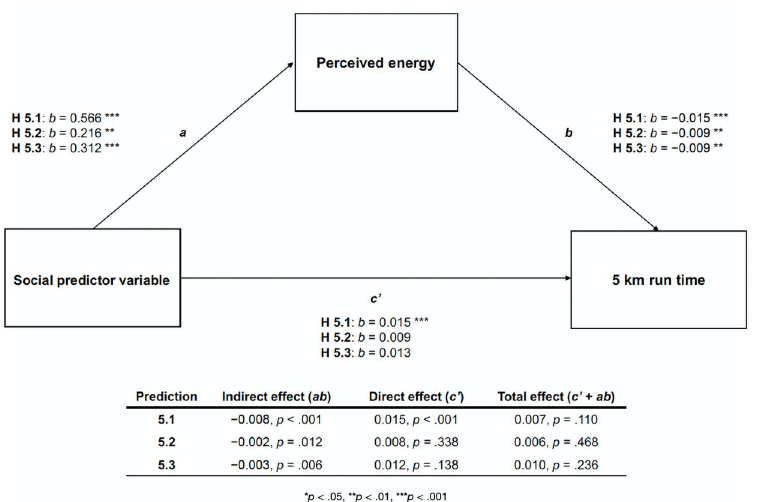
Fig 1. Mediation of social predictors on 5km run times. Mediation diagram depicting the direct, indirect, and total effects of the social predictor variables—the parkrun community component (H5.1), whether or not participants came or met up with family and/or friends (H5.2), and their pre-run sociality (H5.3)–on 5 km run times, with participants’ perceived energy as a potential mediator.